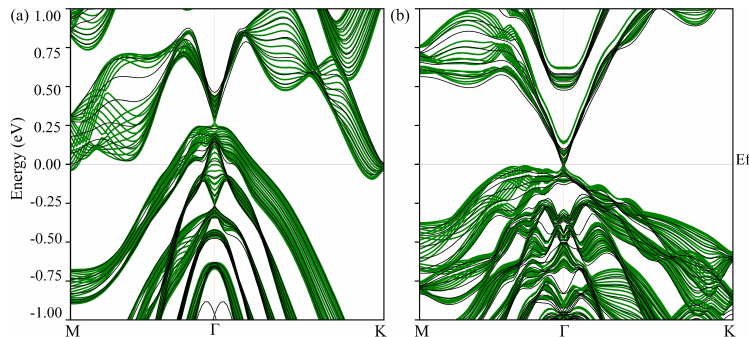
Figure 13. Surface states (black lines) and projected band structure on the (001) plane (green lines) of Bi 2 Te 3 ( a ) and PbBi 2 Te 4 ( b